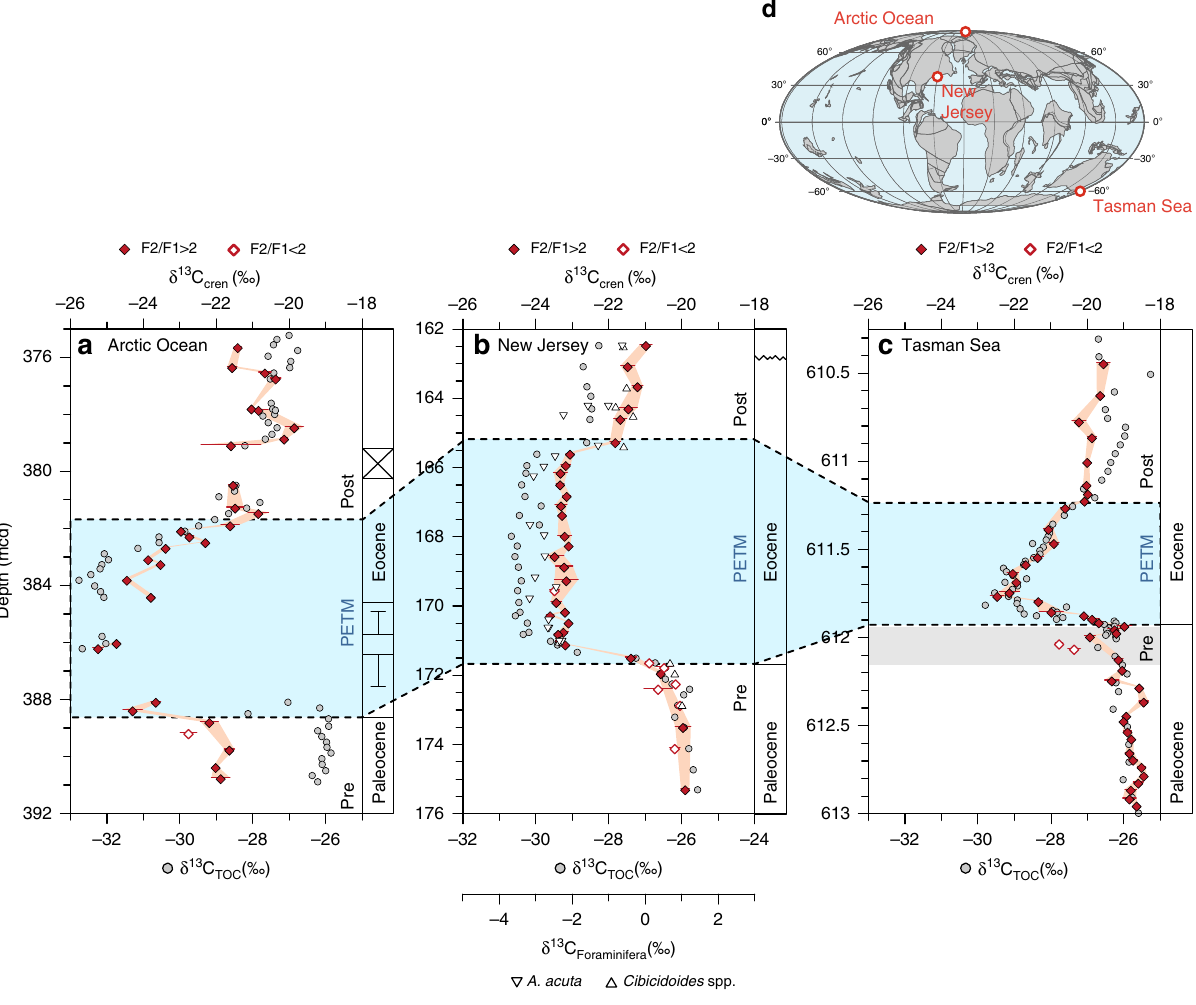
Fig. 1 The Paleocene-Eocene carbon isotope excursion recorded in crenarchaeol and other marine substrates. Carbon isotopic ratios of crenarchaeol ( δ 13 C cren ), total organic carbon ( δ 13 C TOC ; Arctic Ocean, New Jersey: this study; Tasman Sea: ref. 36 ) and the foraminifera Anomalinoides acutus and Cibicidoides spp. ( δ 13 C 37 ) at three globally distributed sites ( a , Arctic Ocean; b , New Jersey shelf; c , Tasman Sea). Foraminifera are preserved Foraminifera ; ref. only in the New Jersey shelf record. Closed and open symbols for δ 13 C cren represent samples with high and low signal-to-background ratios (F2/F1; see Methods), respectively. Error bars of δ 13 C cren represent one standard deviation of replicate analyses ( n = 5). Error bars of δ 13 C cren are not displayed where they are smaller than the symbol. Boundaries of the PETM and pre-onset event are shown in blue (based on refs. 36,42,43 ) and gray shading, respectively. Error bars in the stratigraphic column of the Arctic Ocean record indicate uncertainty in sample position due to poor core recovery. Inset map ( d) shows sampling locations and plate con fi guration (reconstructed using the Ocean Drilling Stratigraphic Network webservice, http://www.odsn.de/ and the model of ref. 77 ) during the late Paleocene (ca. 55